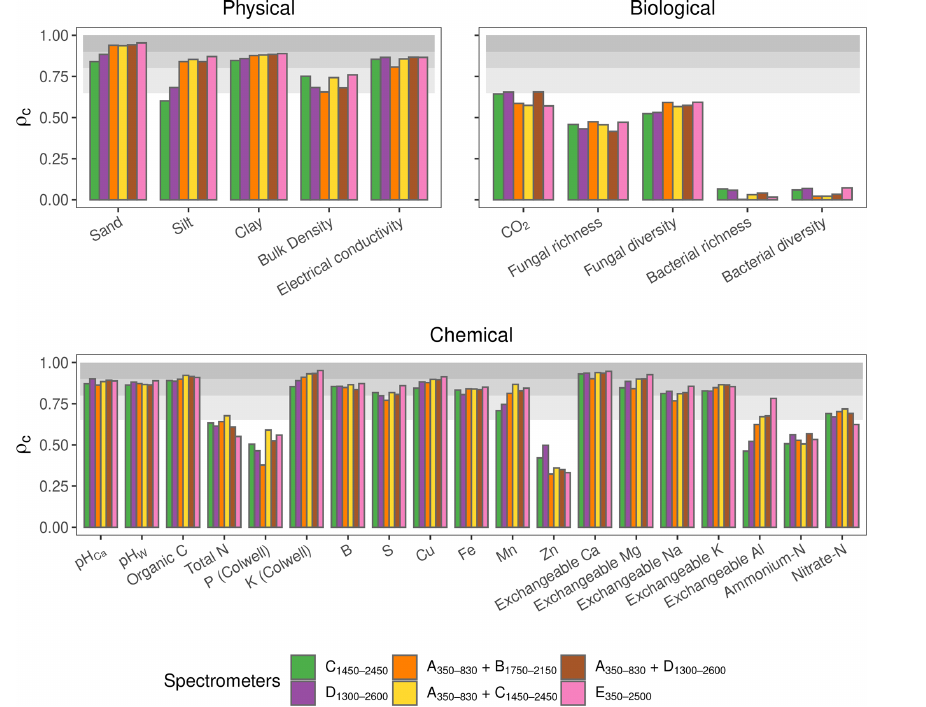
Figure 7. The 10-fold plot-out cross-validation using PLSR with data from